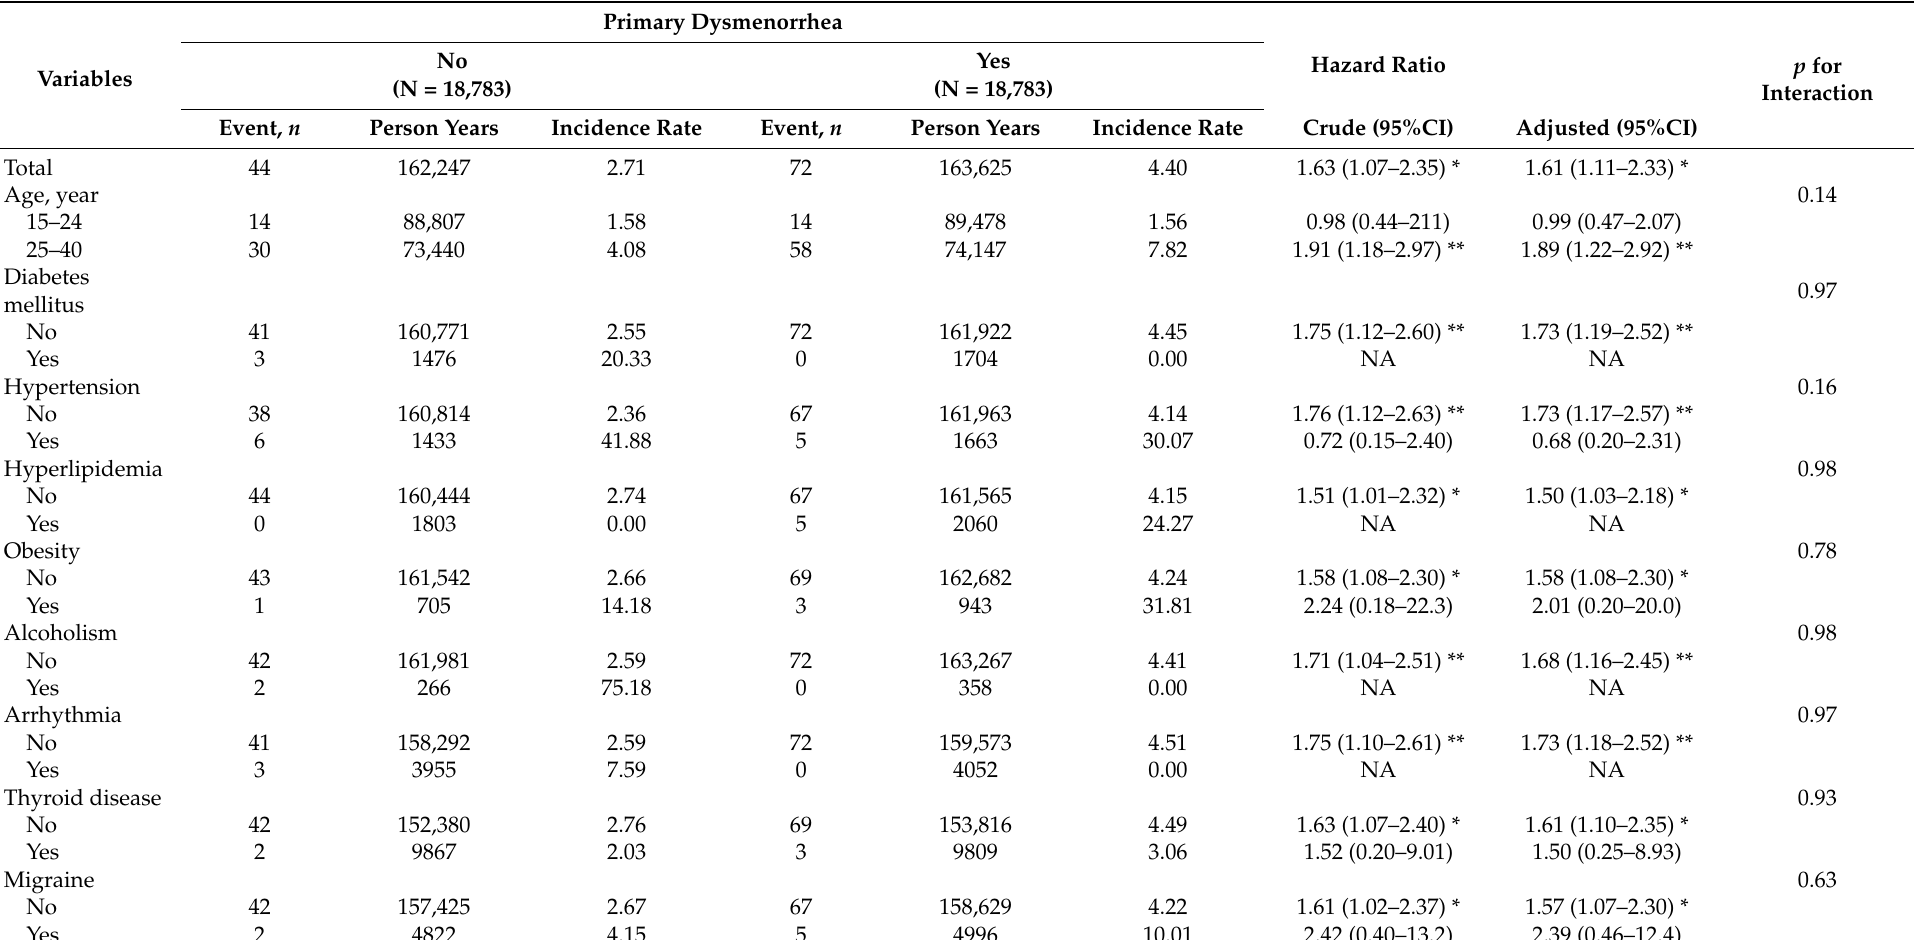
Table 3. Number of ischemic stroke events and incidence rates in in primary dysmenorrhea and comparison cohorts by age, comorbidity, and NSAID use, and Cox model estimated primary dysmenorrhea cohort to comparison adjusted hazard ratios and 95% confidence